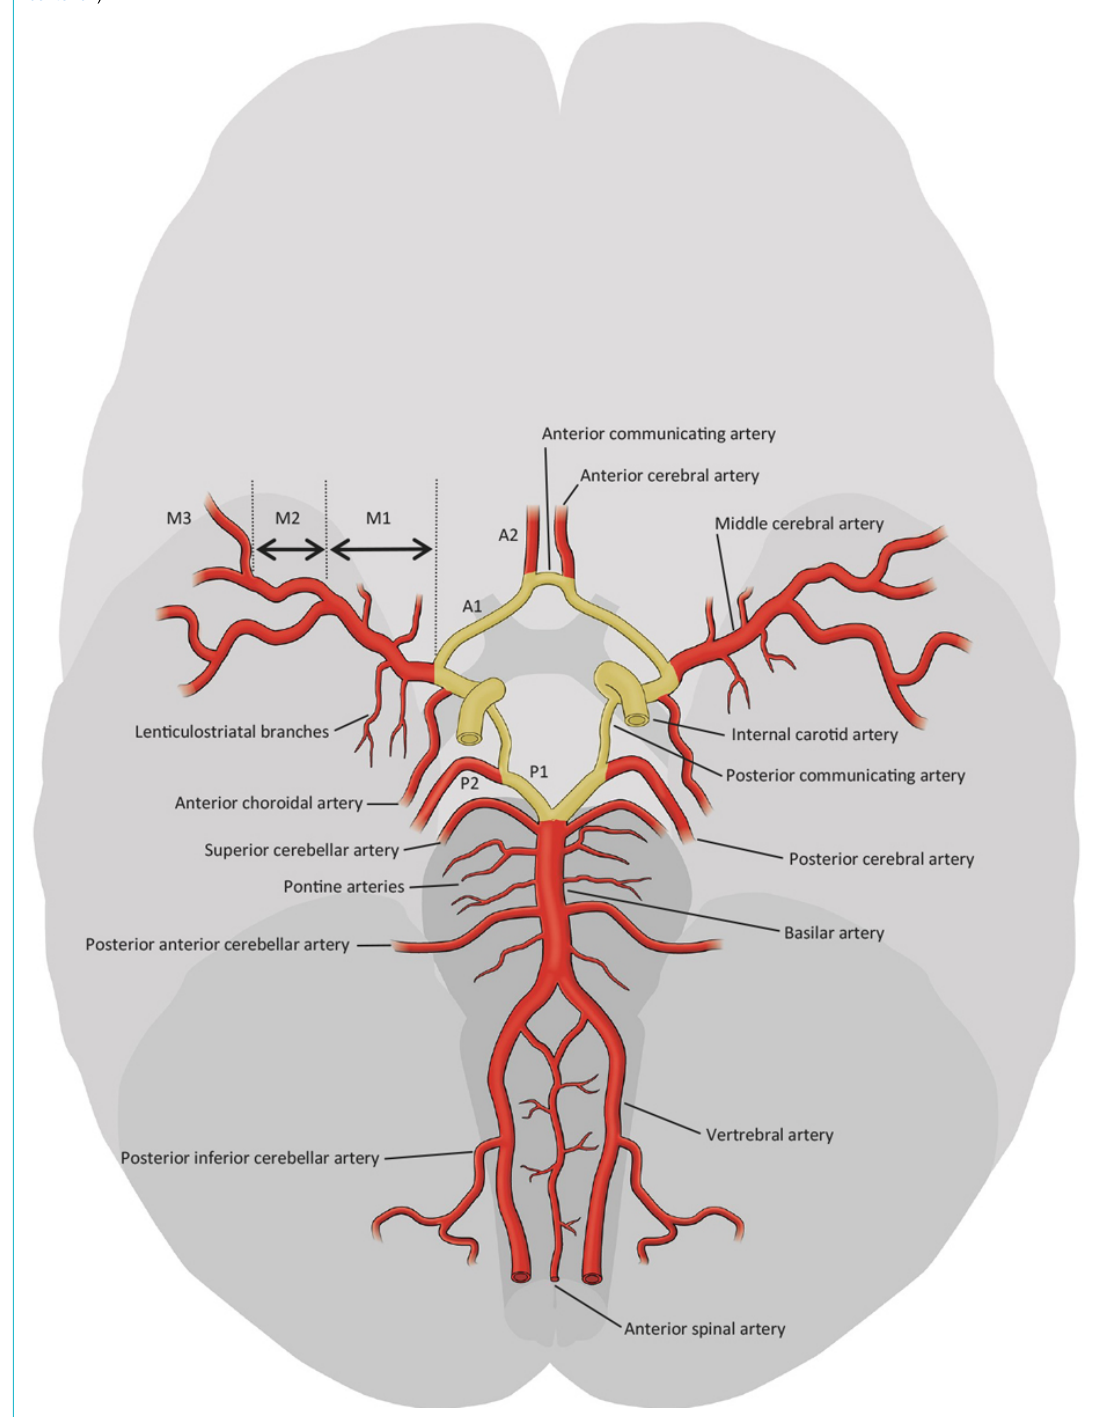
Figure 1: Intracranial vessels. Yellow: Circle of Willis (adapted from the Stroke Guidelines of the University Hospital of Bern 2017, www.stroke-